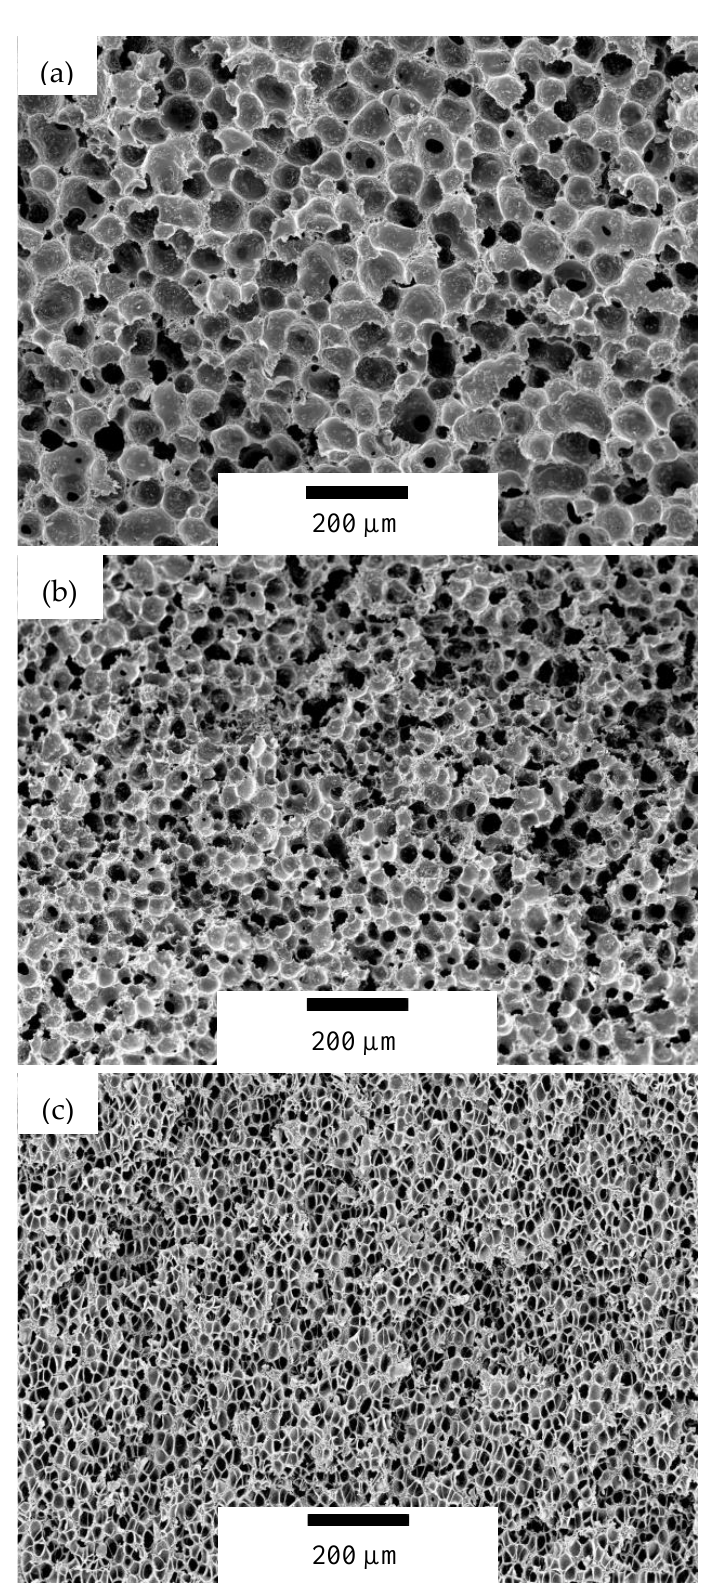
Figure 1. Micrographs at × 95 magnification showing the cellular structure of microcellular nanocomposites containing 2 wt% GnP: ( a ) 15PSU 2, ( b ) 25PSU 2, and ( c ) PSUCO 2 2 samples.